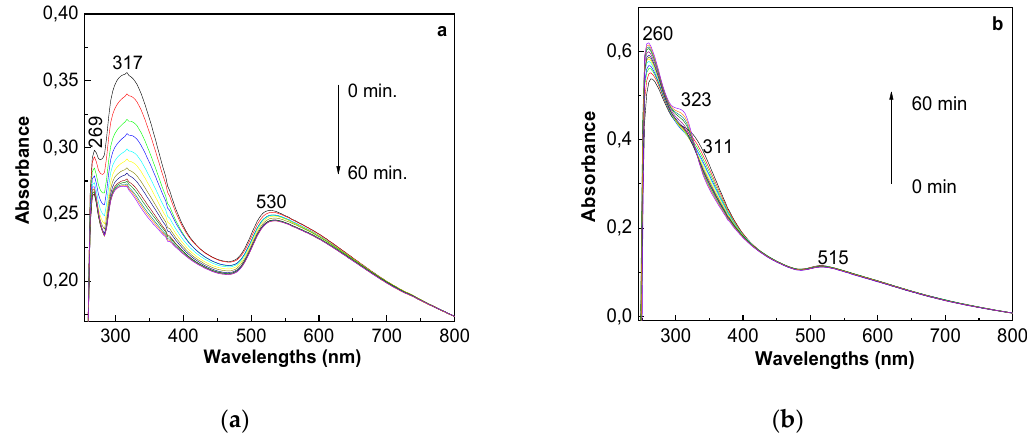
Figure 7. The influence of the UV light on the ALA solution resulting from the dissolution of 1 mg of ALA in the presence of ( a ) 0.5 mg RGO sheets in 1 mL of DMF and 1 mL of Ag nanoparticles with a size of 5 nm and ( b ) 0.5 mg RGO sheets in 1.5 mL of DMF and 0.5 mL of Ag nanoparticles with a size of 5 nm. The black curve in Figure a shows the UV-VIS spectrum of 0.5 mg RGO sheets in 1 mL of DMF and 1 mL of Ag nanoparticles with a size of 5 nm in the absence of ALA. The two samples’ UV-VIS spectra were recorded at intervals of 5 min of exposure to UV light, for 60 min.